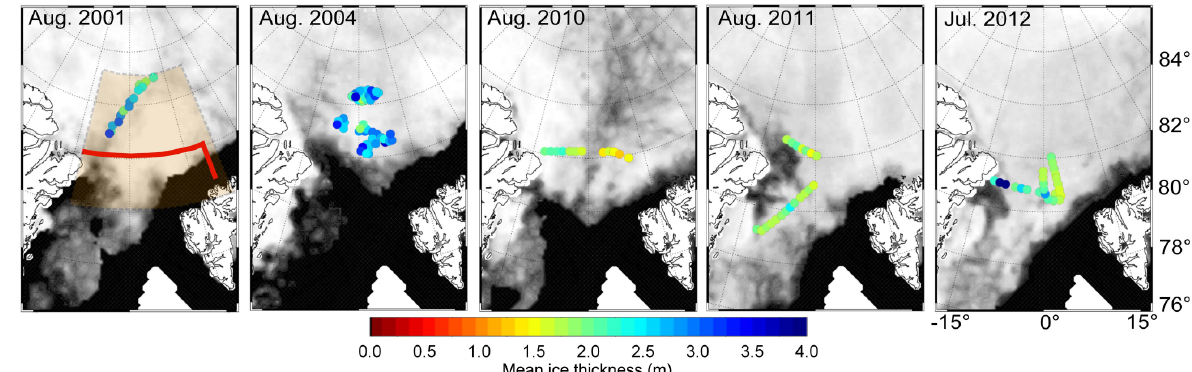
Figure 1. Overview of all EM ice thickness measurements obtained in the Fram Strait region during two cruises with the German ice-breaker RV Polarstern (August 2001 and 2004) and three surveys with the research aircraft Polar 5 (August 2010 and 2011, July 2012). The color coding of the EM profiles corresponds to the mean ice thickness of 10km sections. The light red shaded area marks the area of interest with the data acquisitions used in this analysis. Ice concentration from the date of the first flight of each campaign, is plotted in the background going from 0% ice concentration in black to 100% in white. The thick red line in the left panel indicates the meridional and zonal gates through which satellite-derived ice area fluxes were